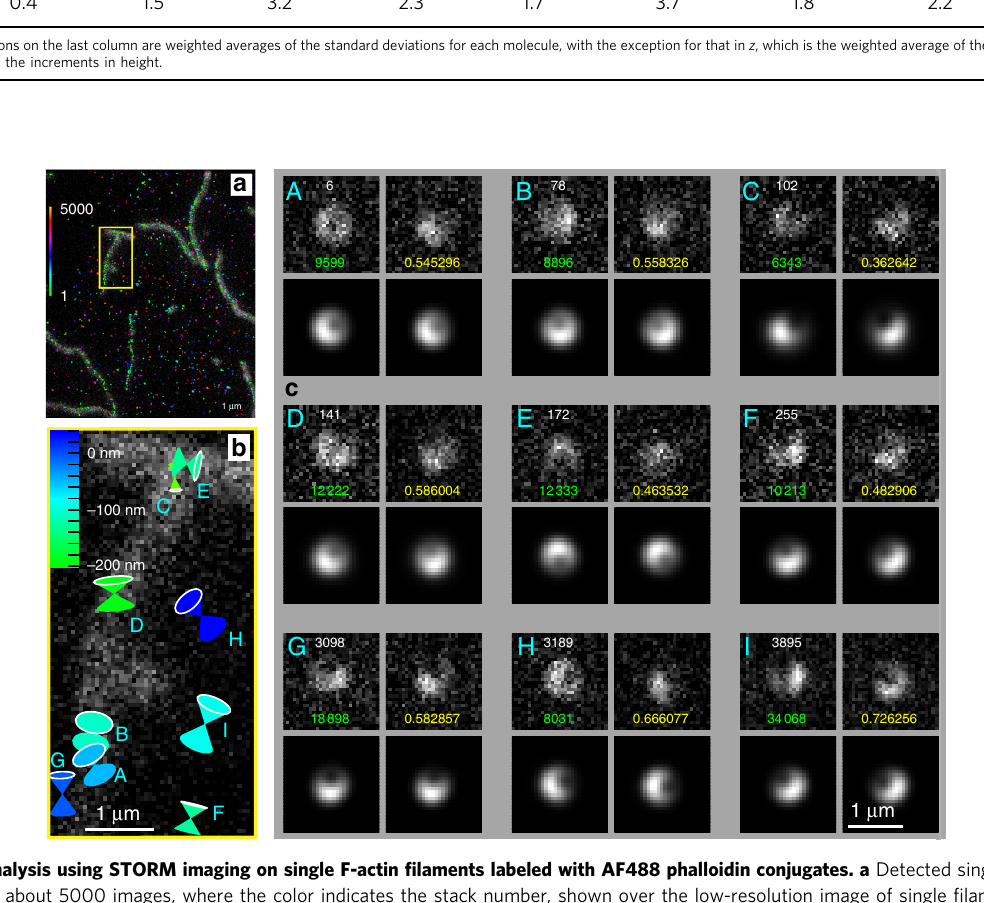
Fig. 8 CHIDO analysis using STORM imaging on single F-actin fi laments labeled with AF488 phalloidin conjugates. a Detected single molecules in a STORM stack of about 5000 images, where the color indicates the stack number, shown over the low-resolution image of single fi laments (gray background). b For the region within the yellow rectangle in ( a ), detected single molecules exhibiting a suf fi ciently high retrieval con fi dence level. The symbols correspond to 2D projection of 3D cone pairs whose vertex encodes x , y , whose color represents height according to the scale, whose orientation represents that of the fl uorophore, whose solid angle represents Ω , and whose size re fl ects the correlation between the detected and model PSFs. c PSF pairs for each of the detected molecules in ( b ), where the top row shows the two detected PSFs and the bottom row the PSFs from the model evaluated at the retrieved parammeters. For each part, the white numbers indicate the frame at which the PSF appeared, the green number gives the estimated number of signal photons, and the yellow number is the correlation between the detected and model